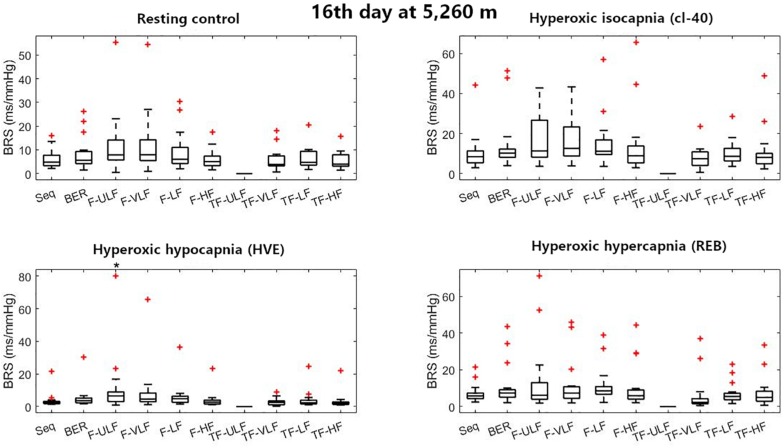
Baroreflex sensitivity estimation for the resting protocol on the 16th day at 5,260 m. cl-40, clamp 40 mmHg of inspired CO2; HVE, hyperventilation; REB, rebreathing up to PACO2 of 50 mmHg. +Denotes outliers. ∗Different from Seq (p < 0.05).